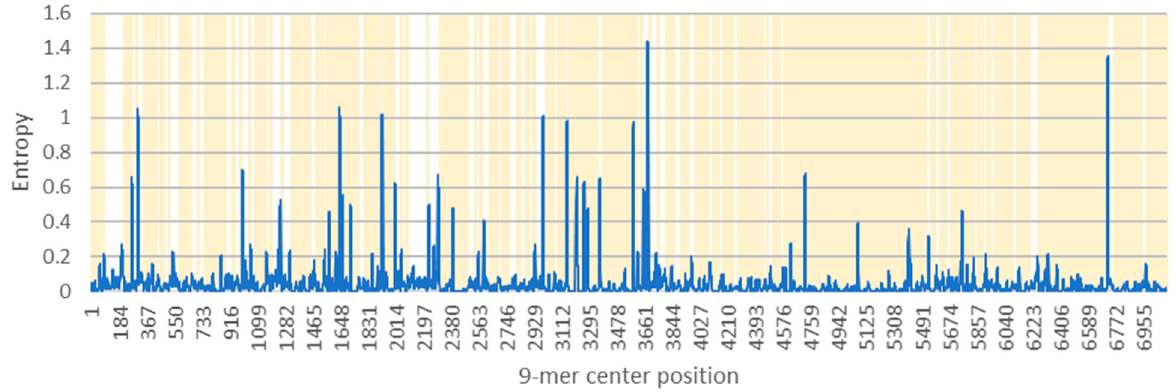
Figure 2. Entropy values of SARS-CoV-2 ORF1ab protein 9-mers. Blue line denotes the entropy values for 9-mer in the corresponding center position. Yellow vertical lines in the background depicts the occurrence of 0 entropy. Table 2. The number of SARS-CoV-2 immunogenic epitopes (T-cell assay positive) as reported in IEDB. The percentage of immunogenic epitopes over the possible number of 9-mer peptides generated by a protein was calculated. The number in bold indicates the percentage of the immunogenic epitopes over the total number of epitopes. IEDB is accessed